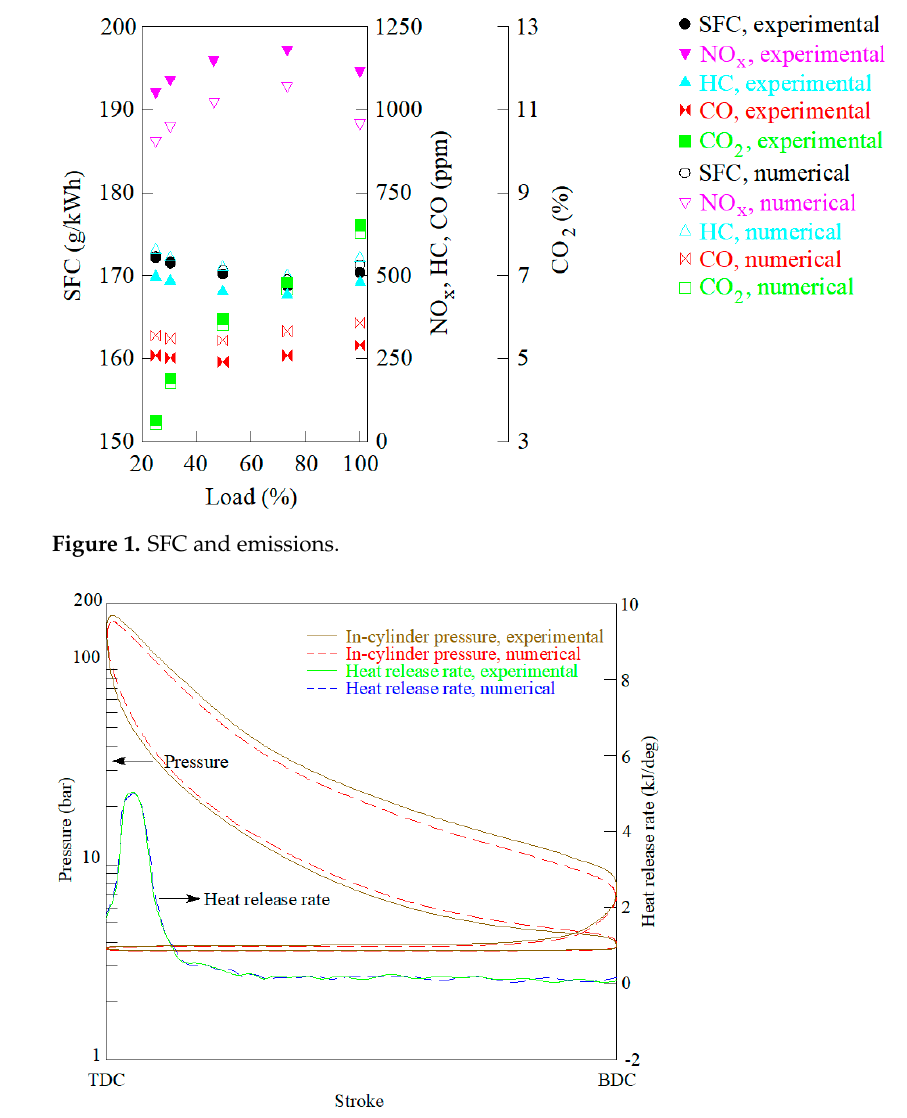
Figure 2. In-cylinder pressure and heat release rate at 100% load.